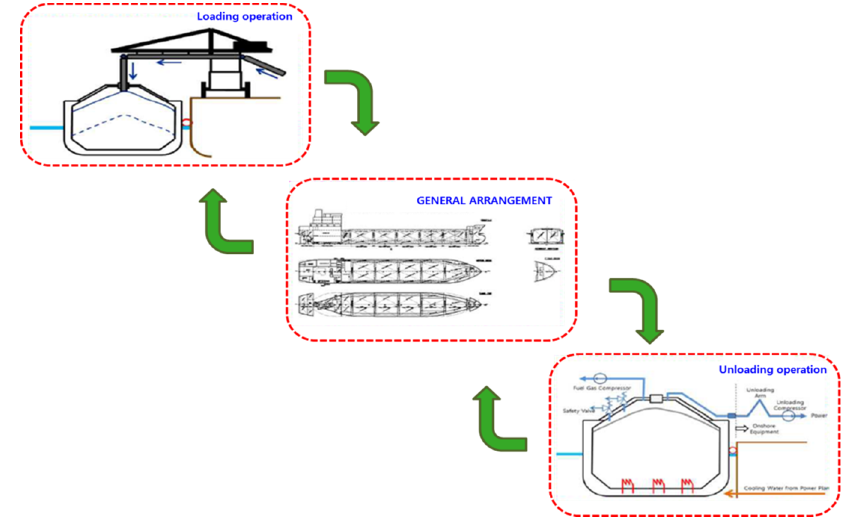
Figure 6. Technologies and system boundaries for HAZID of natural gas hydrate